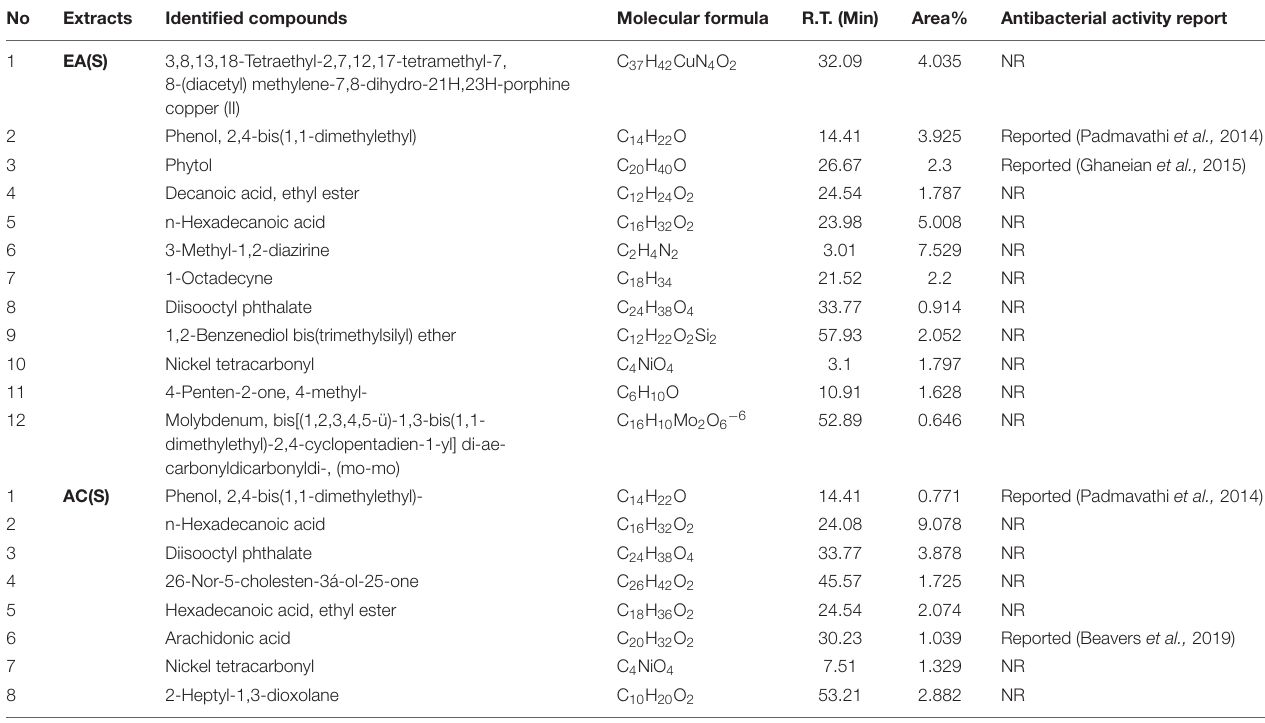
TABLE 3 | Compounds existing in G. edulis ethyl acetate and acetone (S) extract identified by GC-MS analysis.